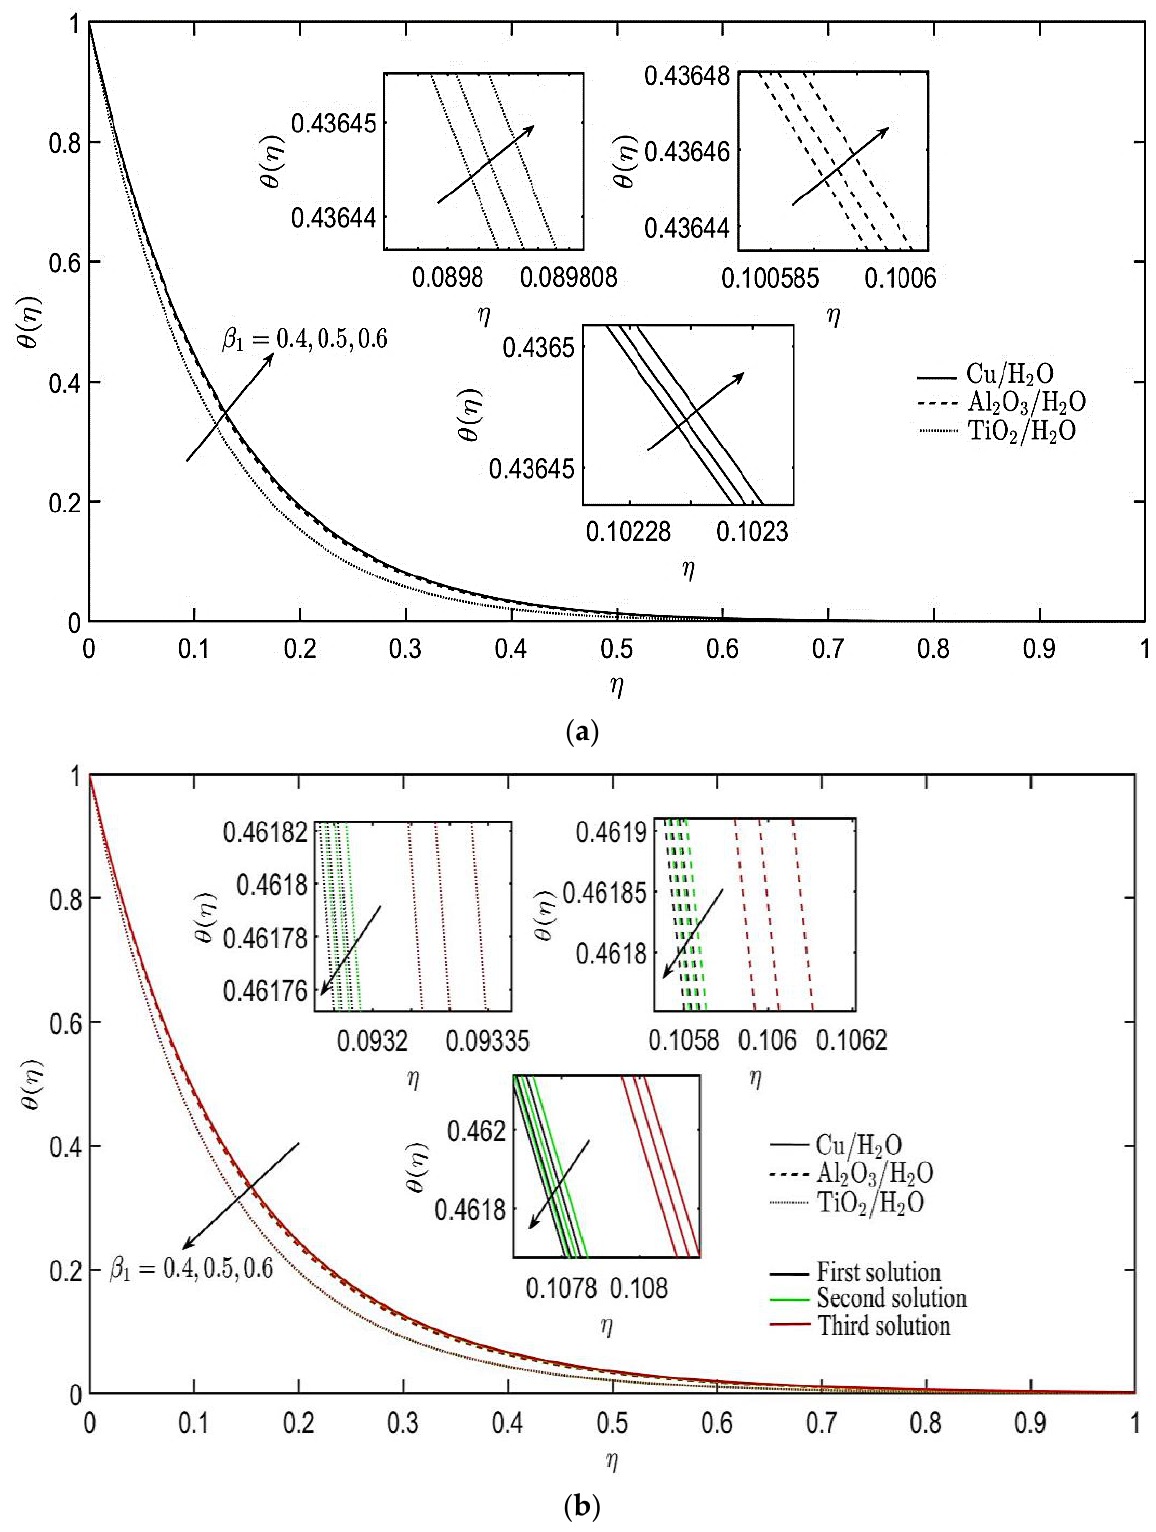
Figure 8. Effect of fluid relaxation time parameter on temperature profiles for: ( a ) Stretching case; ( b ) Shrinking case.